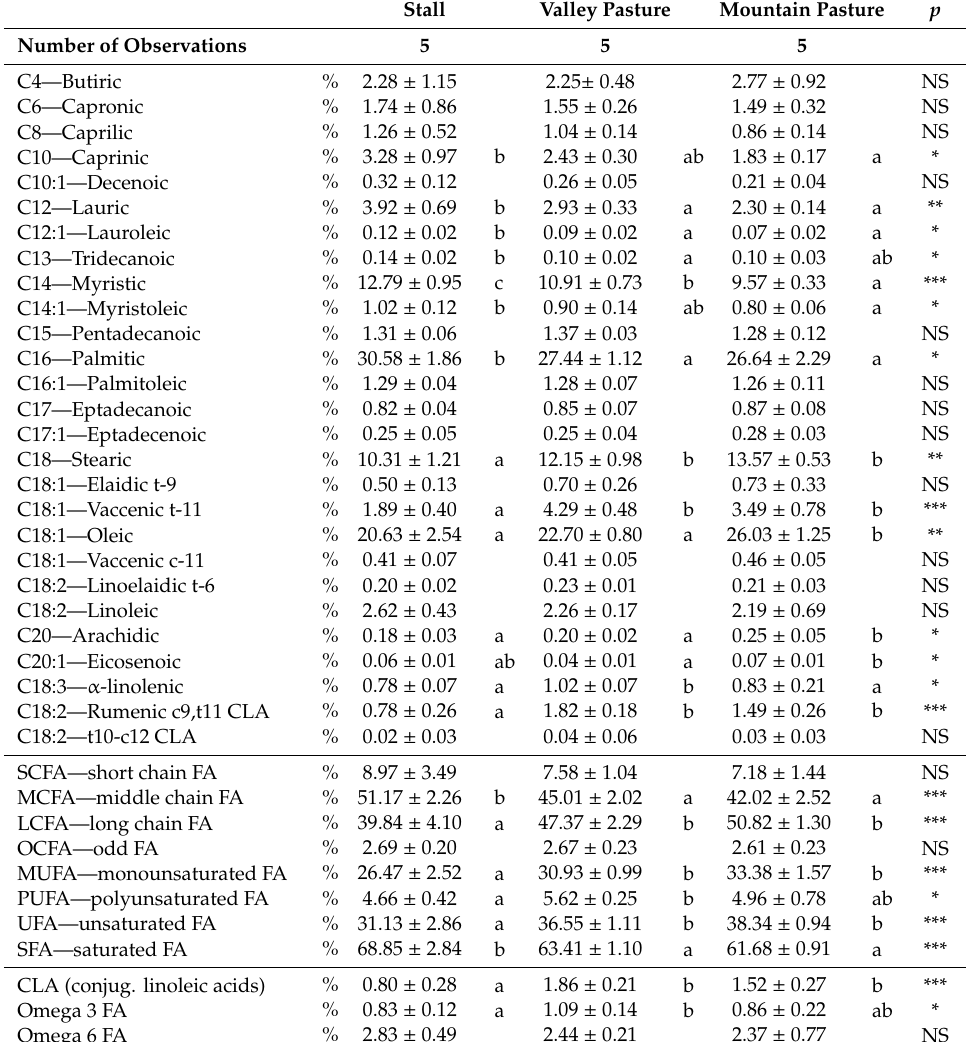
Table 2. Percent distribution of FA of 30 days ripening cheese (comparison between milk produced in stall, valley pasture and mountain pasture). Mean ± SD. a,b,c, di ff er for p < 0.05. NS, p > 0.05; * p ≤ 0.05; ** p ≤ 0.01; *** p ≤